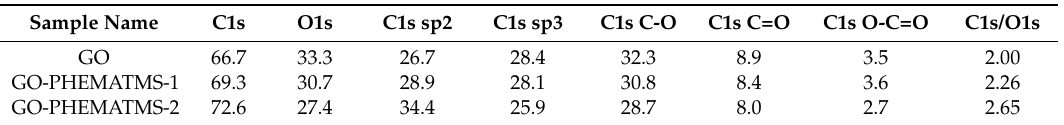
Figure 5. XPS spectra of the neat GO ( a ) and GO-PHEMATMS − 1 particles ( b ). Table 1. The surface chemical composition of the neat GO, GO-PHEMATMS-1, and GO-PHEMATMS-2 particles. All numbers are in atomic %.